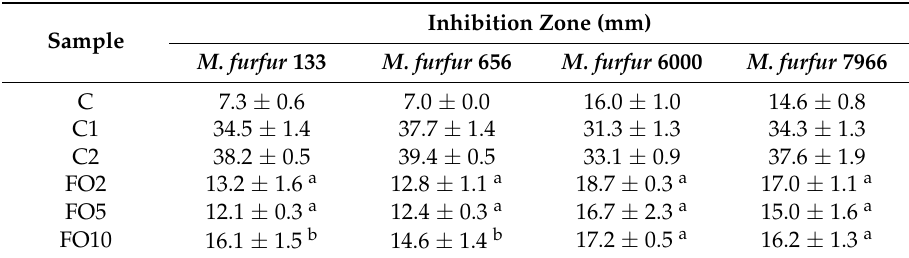
Table 7. Antifungal activity of shampoo containing the fermented product of O. sanctum. Sample